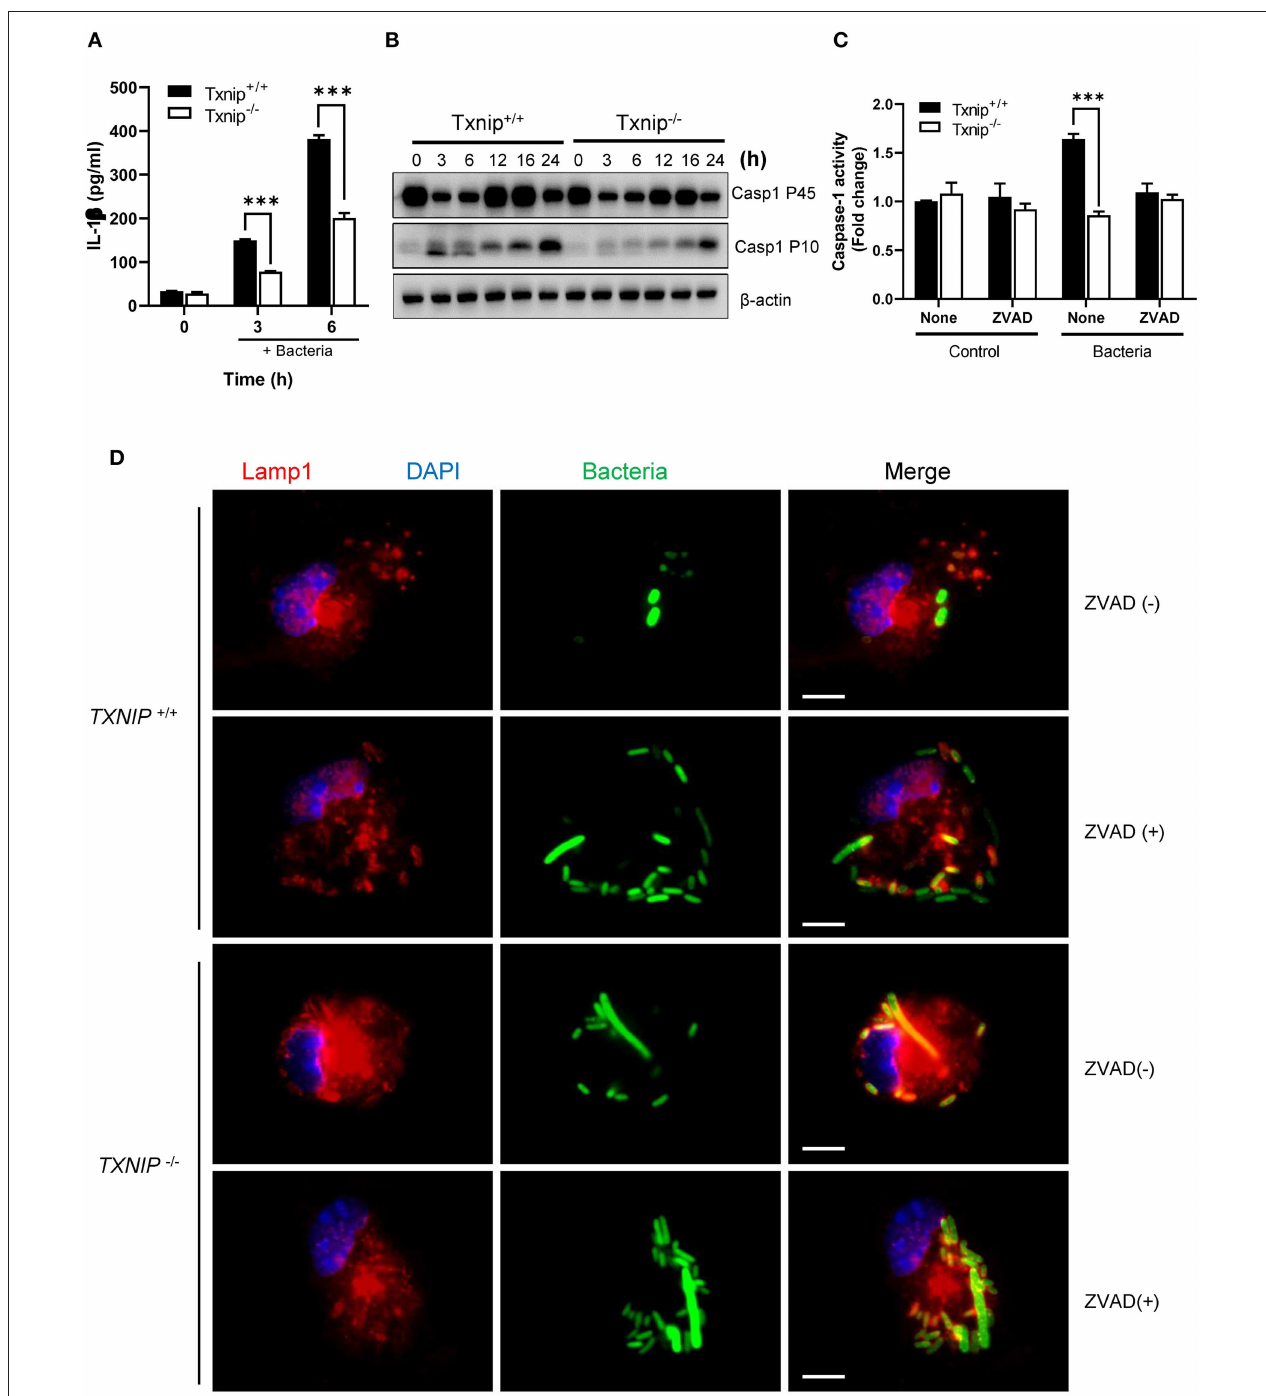
FIGURE 4 | The thioredoxin-interacting protein (TXNIP)-inflammasome-caspase-1 axis regulates the clearance of bacteria from macrophages. (A) The levels of interleukin (IL)-1 β in conditioned media from wild-type (WT) and Txnip knockout (KO) mouse peritoneal macrophages after treatment with E. coli for the indicated times. Data are expressed as the mean ± SD (*** P < 0.001 compared with WT). (B) The protein expression levels of caspase-1 P45 and caspase-1 P10 in mouse WT and Txnip KO mouse peritoneal macrophages after treatment with E. coli for the indicated times. (C) Caspase-1 activity, with or without ZVAD treatment, in mouse WT and Txnip KO mouse peritoneal macrophages 6h after the treatment with E. coli . Data are expressed as the mean ± SD (*** P < 0.001 compared with WT). (D) Representative images of bacteria-laden WT and Txnip KO mouse macrophages 6h after a 1-h treatment with GFP-expressing E. coli with or without ZVAD treatment and removal of extracellular bacteria. Scale bar, 10 µ